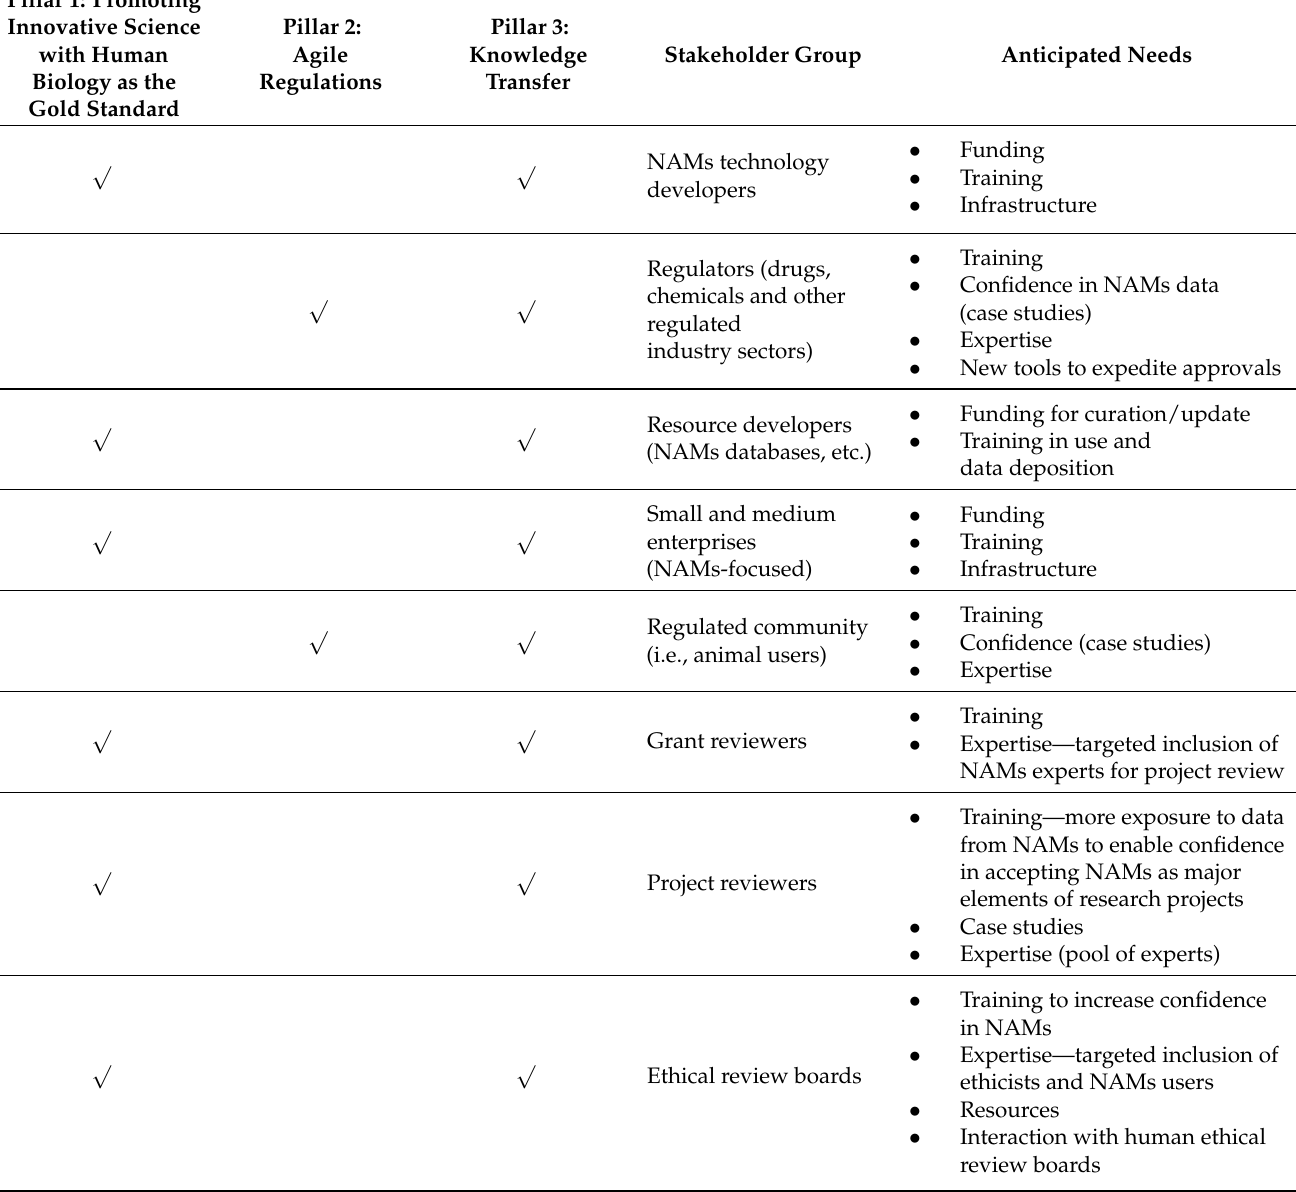
Table 1. Stakeholder identities, anticipated needs, and the pillar into which these activities may